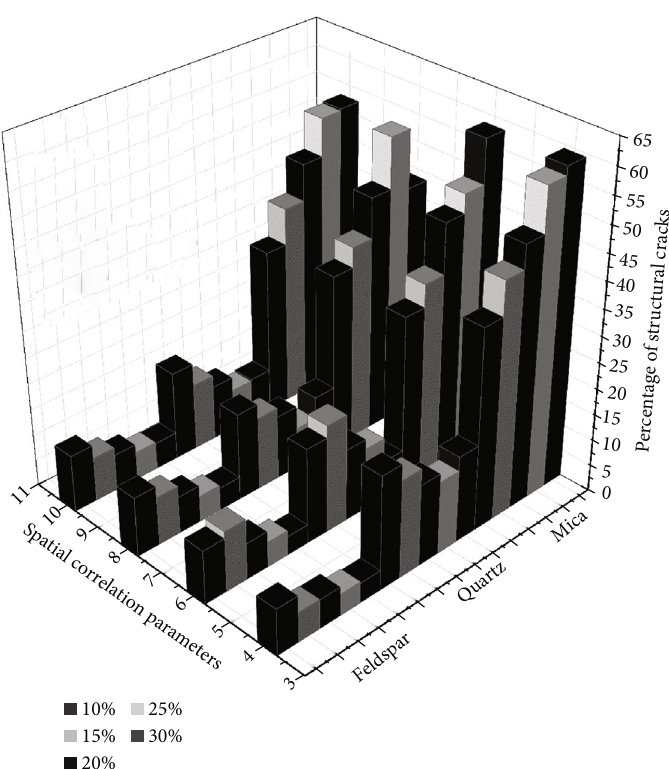
Figure 17: The relationship between the content of microcracks in di ff erent components and the L